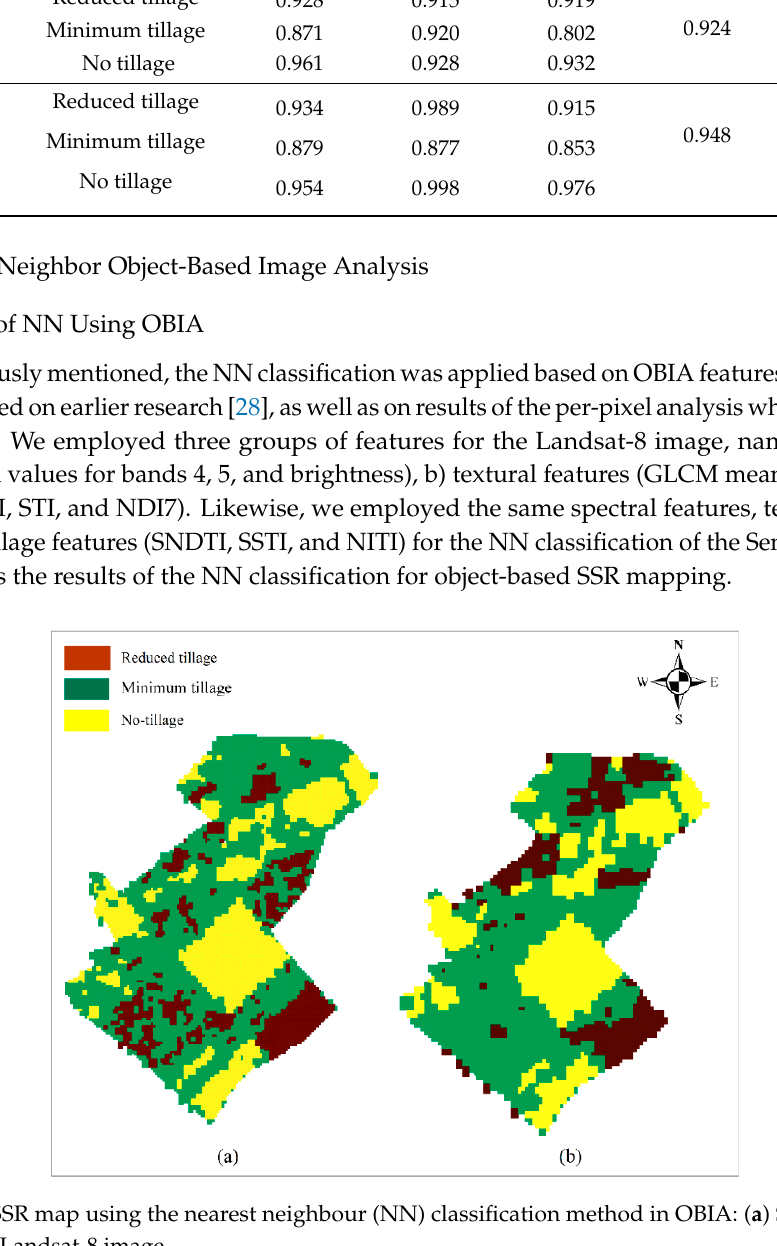
Table 7. Accuracy assessment of the NN classification method using OBIA for Landsat-8 and Sentinel-2A images. Sensors